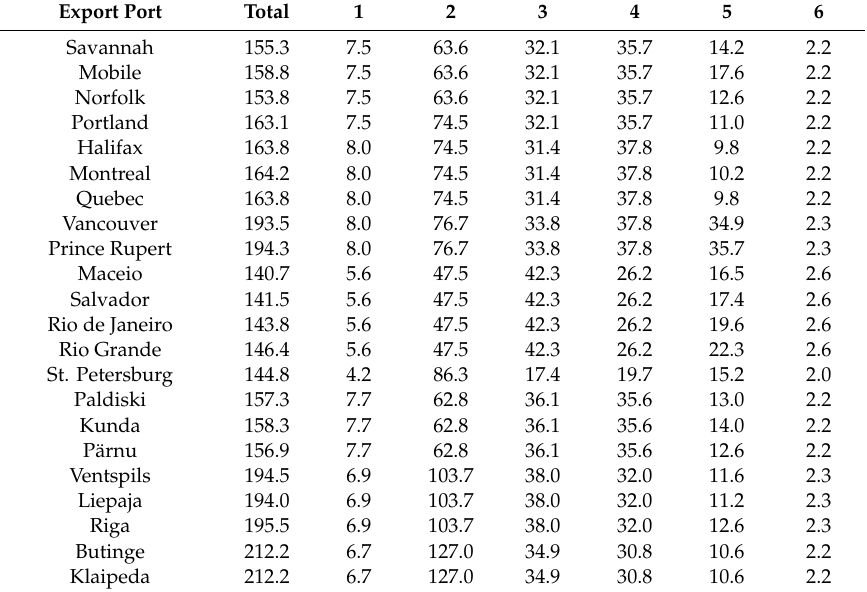
Table A10. Overview of supply chain costs of torrefied pellets produced from sawmill residues, transported over 500 km to export ports and including 50 km feedstock transport, in € / t pellets. Components included in the table: 1. Feedstock transport; 2. Feedstock; 3. Pelletizing; 4. Pellet transport; 5. Shipping; 6. Port operations.